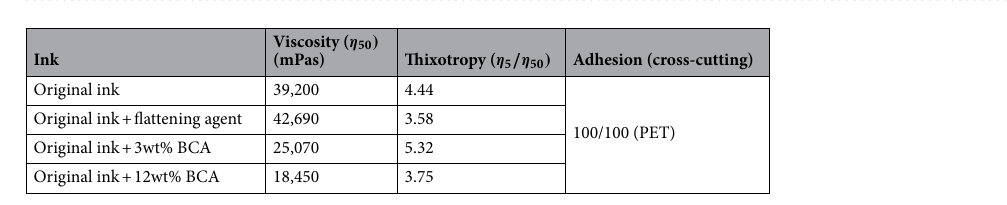
Table 1. Conductive inks properties (from